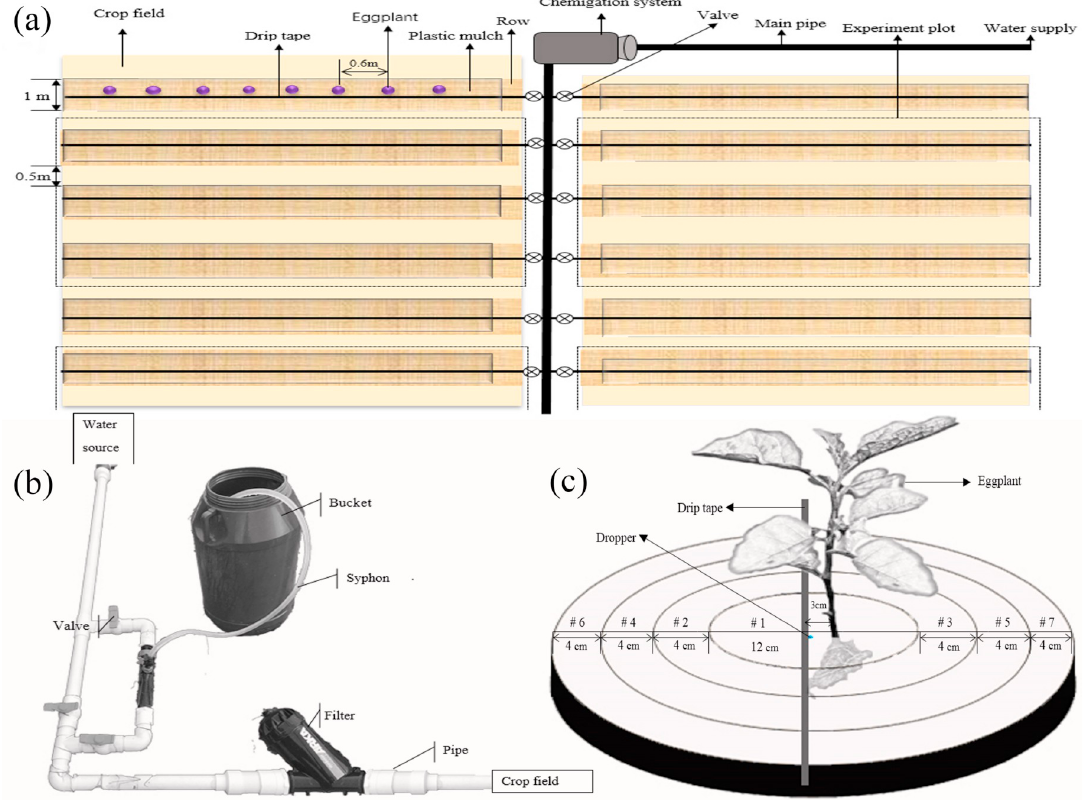
Fig 1. Survey of field experiment. (a) Survey of field experiment plot. (b). Detail of chemigation system. (c) Sampling spots.